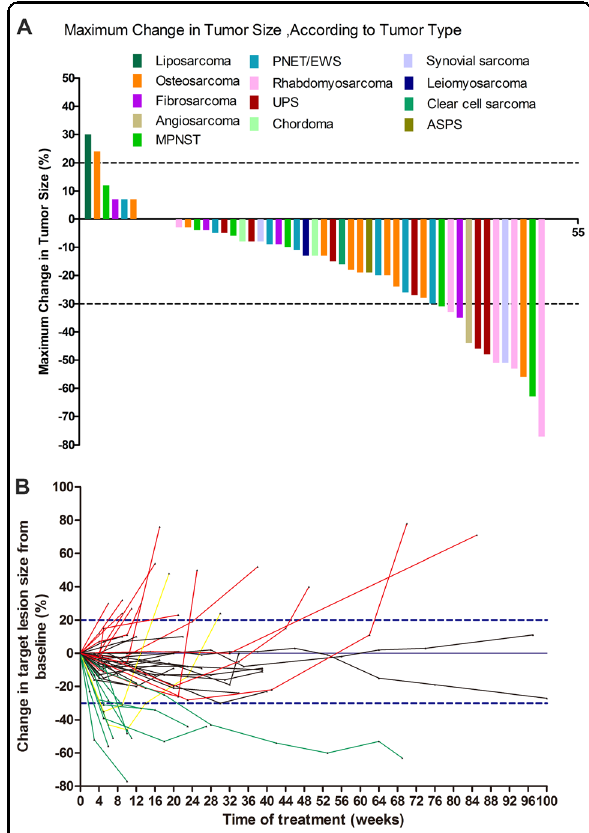
Fig. 1 Maximum changes and all changes from baseline in target lesions in patients with stage IV sarcomas treated with apatinib. a Maximum changes in target lesions in patients with stage IV sarcoma treated with apatinib. Among 64 patients, 51 were evaluated for response to apatinib (RECIST 1.1). No patients achieved CR, 13 (25.49%) achieved PR once, and 36 (70.59%) achieved SD once. Only two (3.9%) patients suffered from PD, and 49 (96.1%) responded to apatinib monotherapy. b Changes from baseline in target lesions after apatinib treatment in 51 patients with measurable sarcoma lesions. Green lines: target lesions shrank ≥ 30% from baseline; red lines: target lesions increased ≥ 20% from baseline; yellow lines: target lesions initially decreased ≥ 30% and then increased ≥ 20% from baseline; black lines: target lesions changed from 20% – 30%